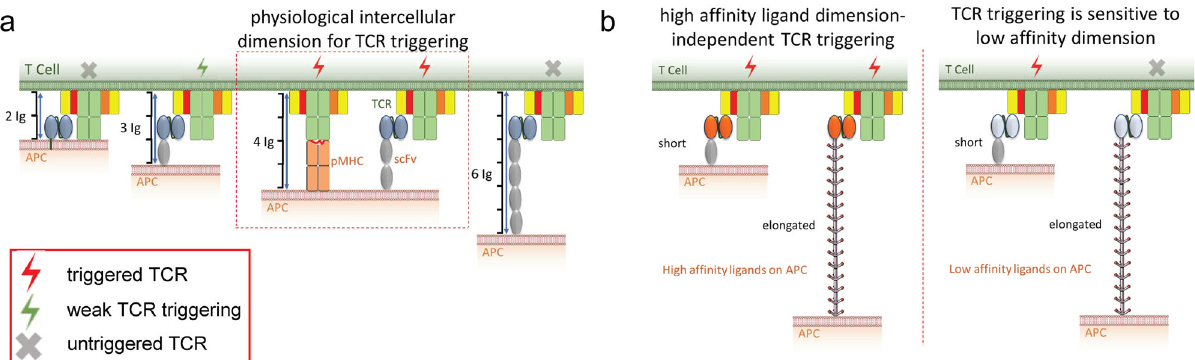
Fig. 7 T cell activation requires ligands with particular dimensions. a TCR triggering is achieved when the interspatial distance between T cells and APCs is around physiological dimensions which is 4 Ig-like domains (~15 nm). Similar results are obtained using arti fi cial APCs expressing membrane-bound anti- CD3 scFv elongated with different tethers. b High-af fi nity TCR ligands tethered on arti fi cial APCs can trigger TCR signaling independent of their dimensions (left) while low-af fi nity TCR ligands lose their potency to activate TCR